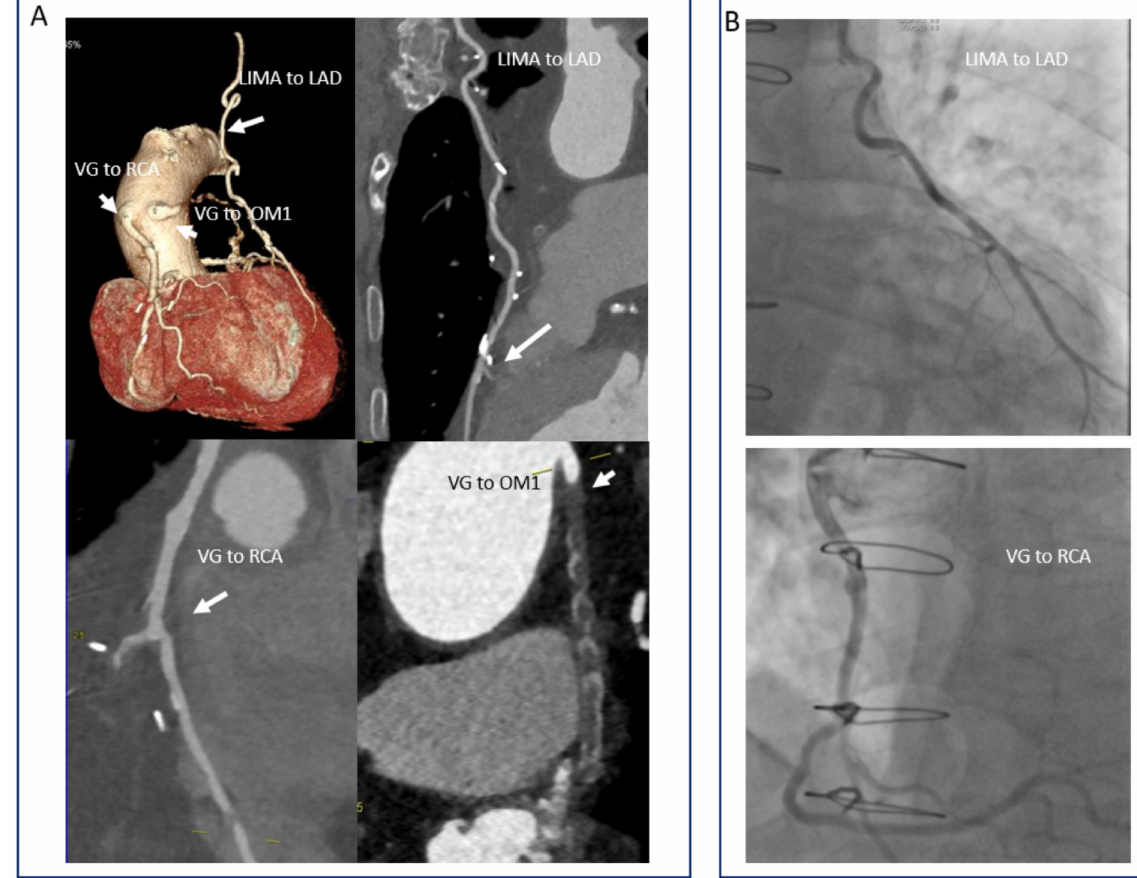
Figure 11. CCTA in the evaluation of coronary artery bypass patients ( A ). Note the patency of the LIMA to LAD and VG to RCA. The VG to the first obtuse marginal is occluded. Corresponding images from the coronary angiography ( B